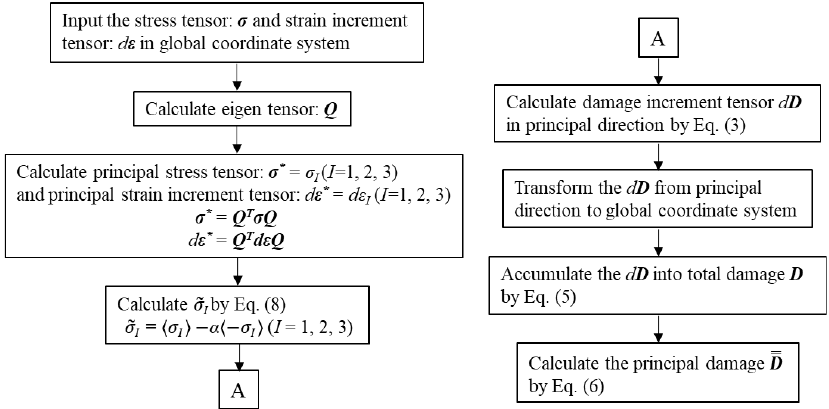
Figure 1. Calculation flow chart of damage equation considering compressive stress.